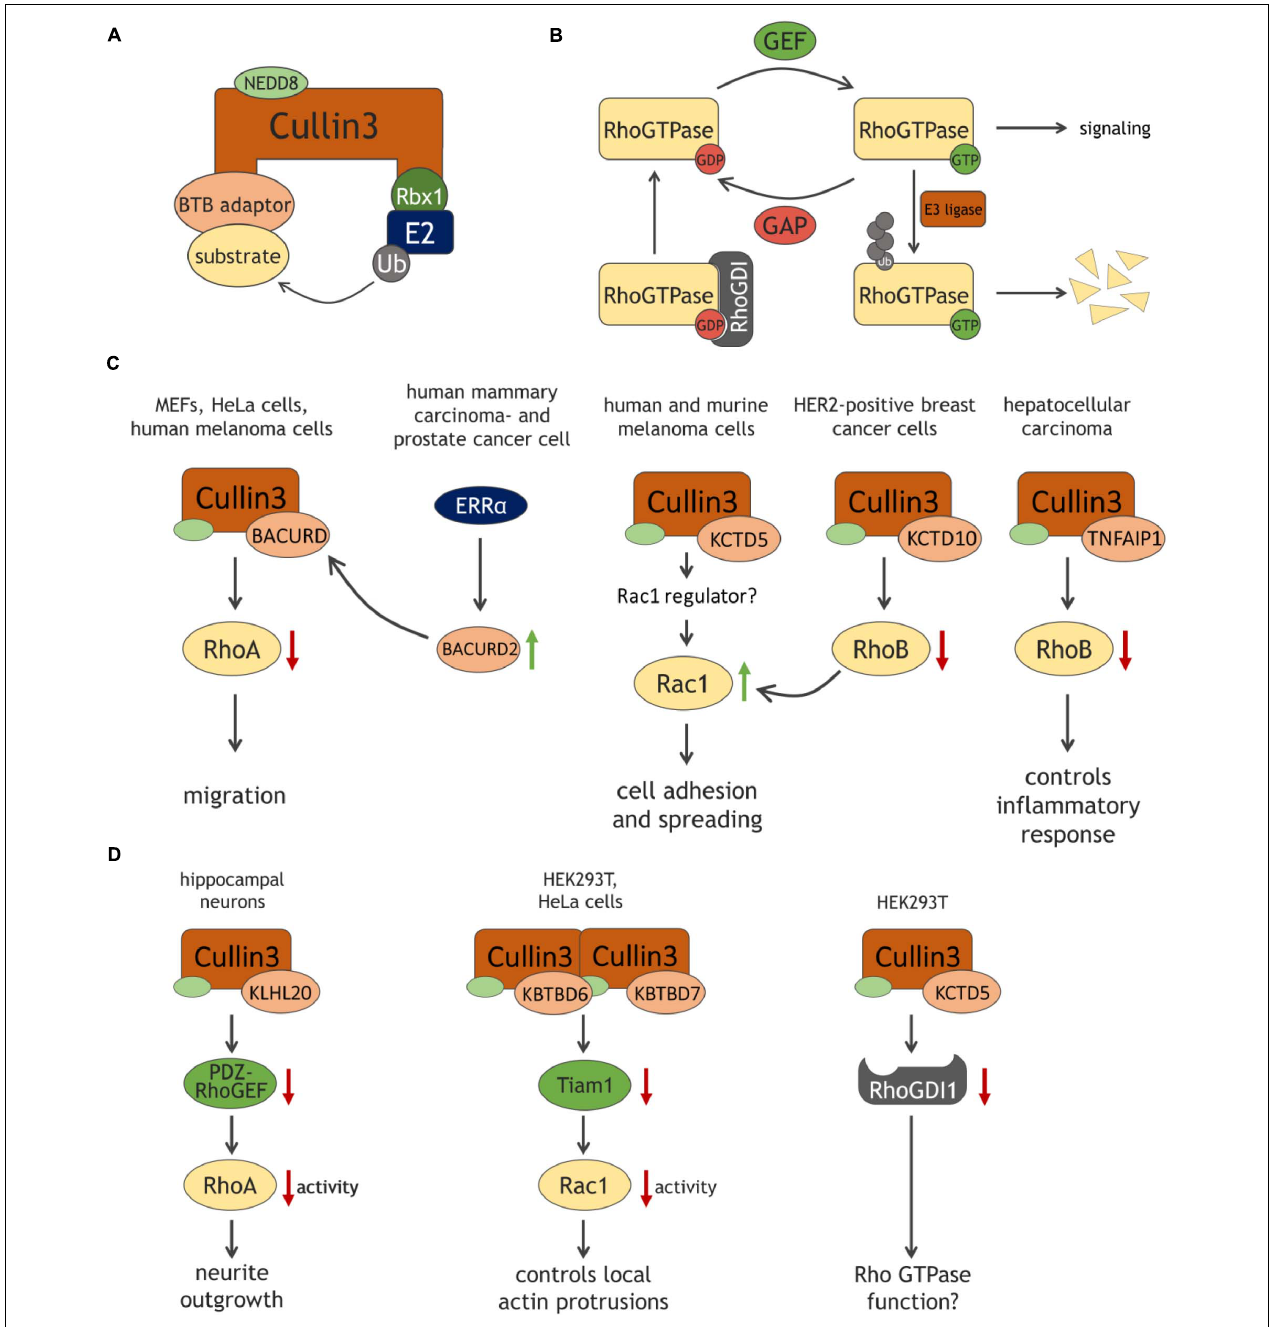
FIGURE 1 | Schematic representation of the Cullin3 E3 ligase complex (A) and of the Rho GTPase cycle (B) , with ubiquitination as an additional level of control of GTPase expression and signaling output. (C,D) Cullin3-BTB complexes target Rho GTPases and their regulators in various cell types. See text and list of abbreviations for